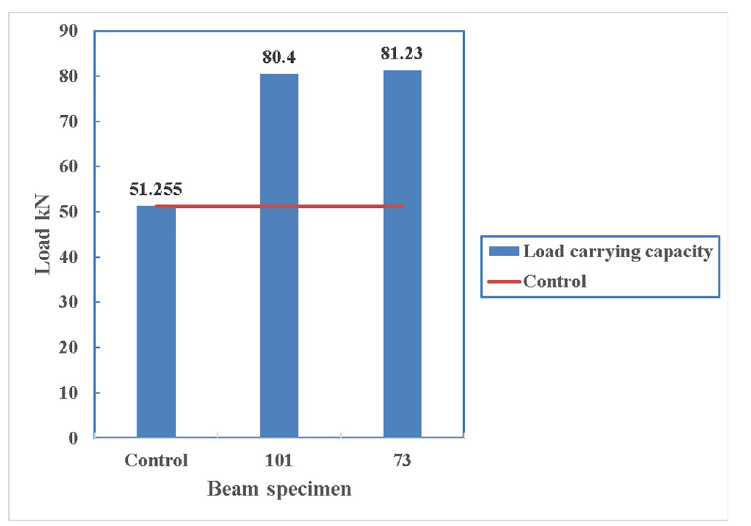
Fig 28. Load carrying capacity of beam 101 and beam 73.